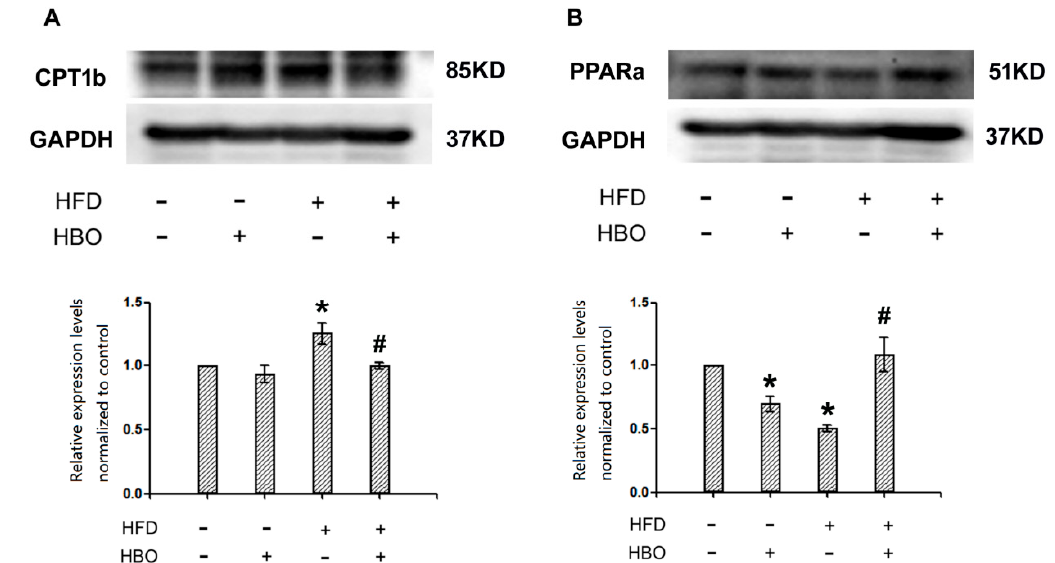
Figure 9. Western blotting for CPT1b and peroxisome proliferator-activated receptor alpha (PPAR α ) in skeletal muscle. Skeletal muscle samples from C57 / B6 mice were homogenized in RIPA bu ff er with 1:100 PMSF, centrifuged at 14,000 × g for 10 min, and the resulting supernatants were subjected to western blotting analysis for CPT1b and PPAR α . Images were acquired from a Vilber Lourmet gel imaging system and analyzed with ImageJ. 3 samples from independent animals were included per group. Error bars represent standard derivation. ( A ): Representative blot images and quantifications of CPT1b. ( B ): Representative blot images and quantifications of PPAR α . *: statistically di ff erent from control group animals ( p < 0.05). #: statistically di ff erent from HFD group animals ( p < 0.05).